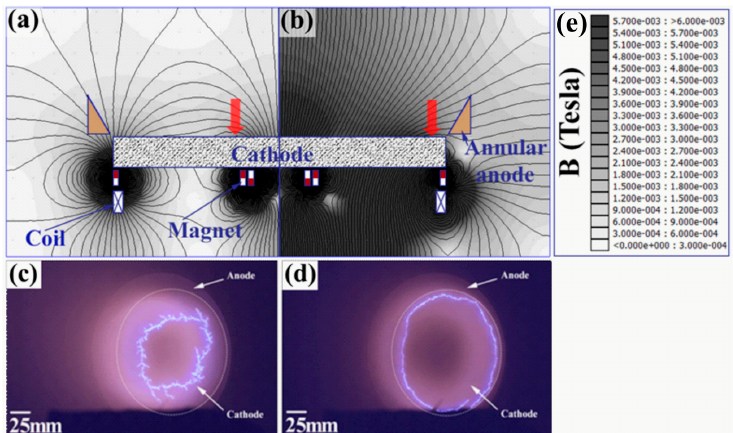
Figure 2. Schematic representation (not to scale) of the cathode, annular anode, and magnetic system (permanent magnet rings and electromagnetic coil) with simulated magnetic flux density for the coil currents of 0 ( a ) and 2 A ( b ), the strength of magnetic flux density is proportional to the greyscale color which can be read from (e). The approximate regions where the magnetic field lines are parallel to the cathode surface are indicated by arrows. Images of Ti 0.33 Al 0.67 cathode surfaces during arc evaporation (180 A arc current, 3.5 Pa of N 2 ) were recorded with a high-speed camera placed at 45 ° with respect to the surface normal and using an exposure time of 130 µs for each frame. In ( c ), the coil current is 0 A, and the image is the sum of 45 frames, and in ( d ), the coil current is 2 A coil, and the image is the sum of 71 frames. Coatings 2019 , X , x FOR PEER REVIEW